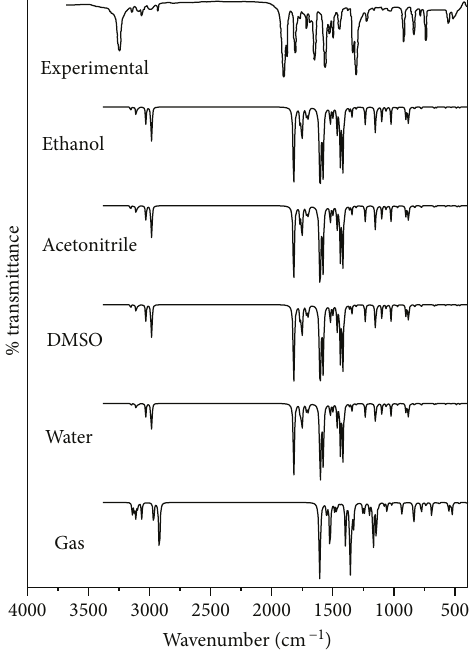
Figure 2: Computed (scaled) IR spectra of DMAB by DFT/6-311G ++ in di ff erent solvents with the experimental FTIR